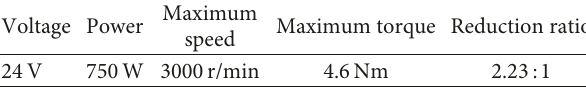
Table 2: Primary parameters of